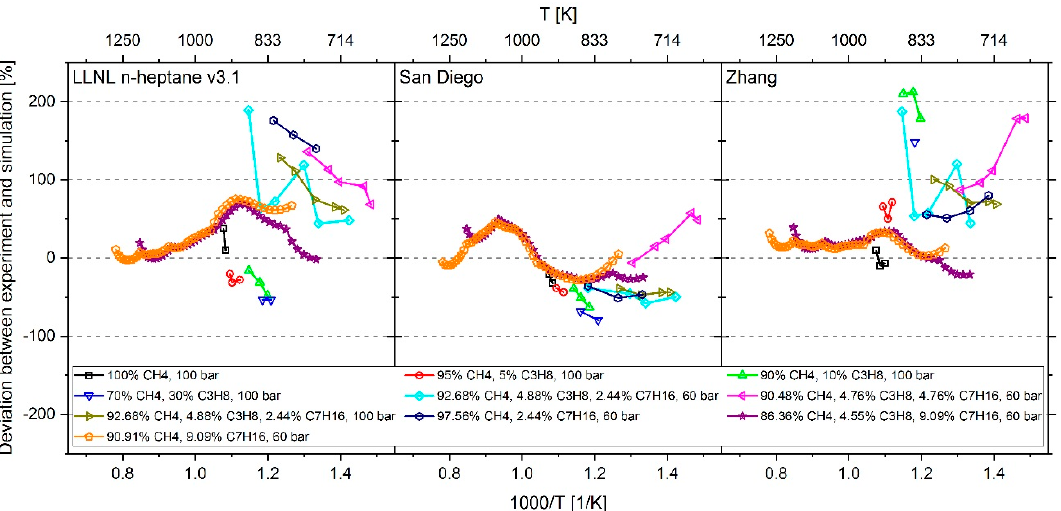
Figure 10. Percentage deviation between measurement data and simulation results using the mechanism LLNL n -heptane v3.1 [23] (left), Complete San Diego mechanism with n -heptane extension [20] (middle) and the mechanisms of Zhang et al. [21] (right).